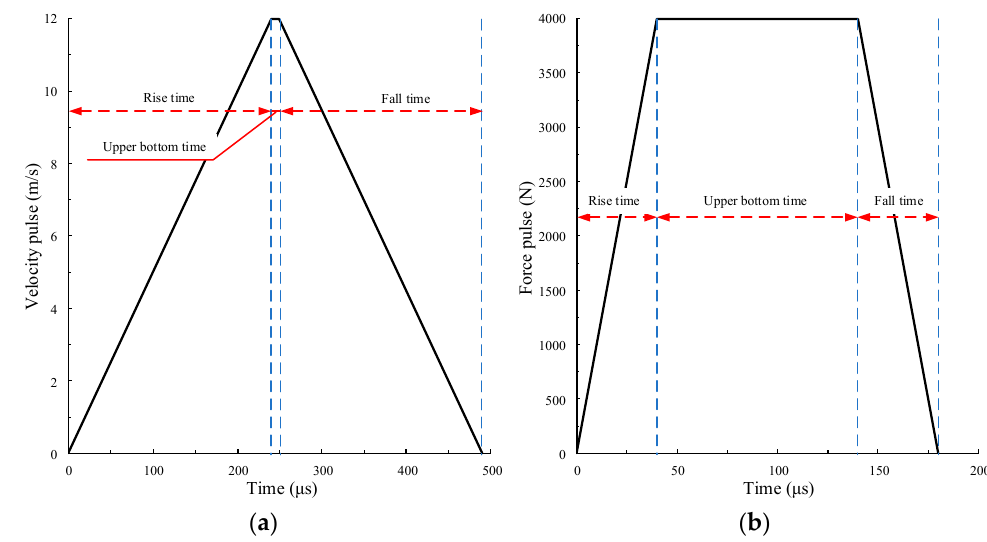
Figure 3. Typical pulse waveforms. ( a ) Velocity pulse; ( b ) force pulse. Using the pulse waveform curve in Figure 3b, the stress waveform on the Hopkinson bars is obtained, as shown in Figure 4. In the figure, the stress waveforms measured by measuring circles 1, 2, and 3 on the incident bar are almost the same, indicating that the waveform has no obvious dispersion phenomenon. Additionally, the stress waveforms measured by measuring circles 1, 2, and 3 on the incident bar are almost the same, indi- cating that the incident wave has no obvious dispersion phenomenon. Thus, it can be de- termined that the established SHPB numerical model is basically reliable.